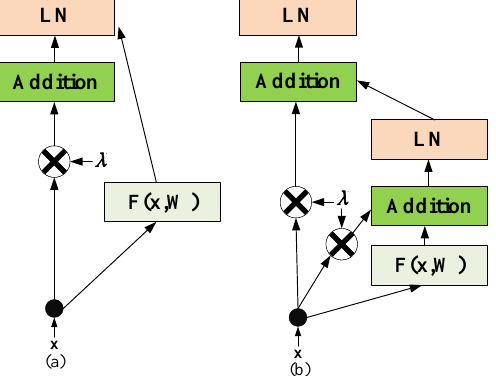
Figure 5. Skip connection structures in